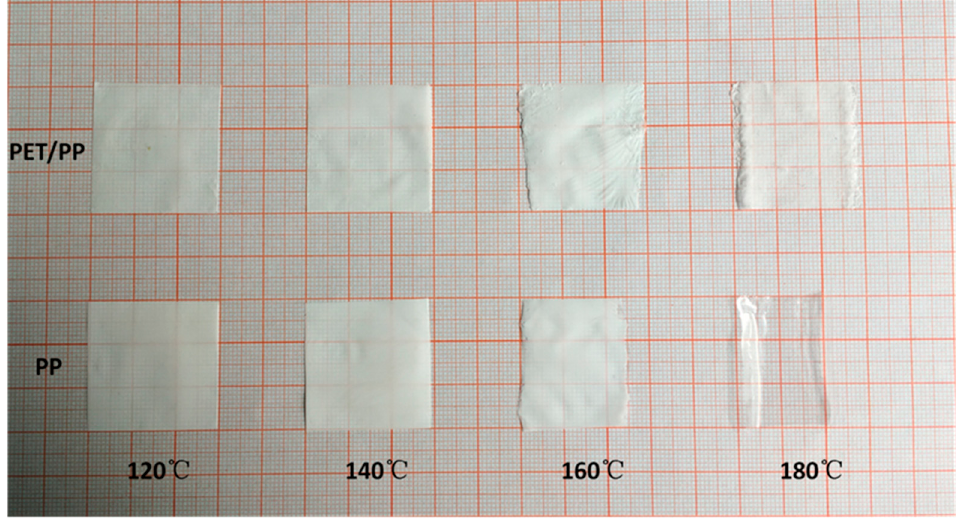
Figure 9. Photography of changes in the separator profile as a function of temperature.